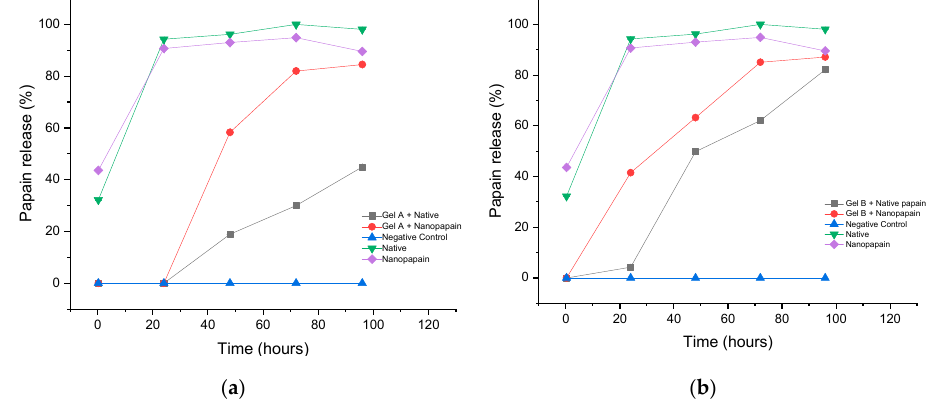
Figure 5. Papain release assessment in gel A ( a ) and gel B ( b ) ( λ = 280 nm).